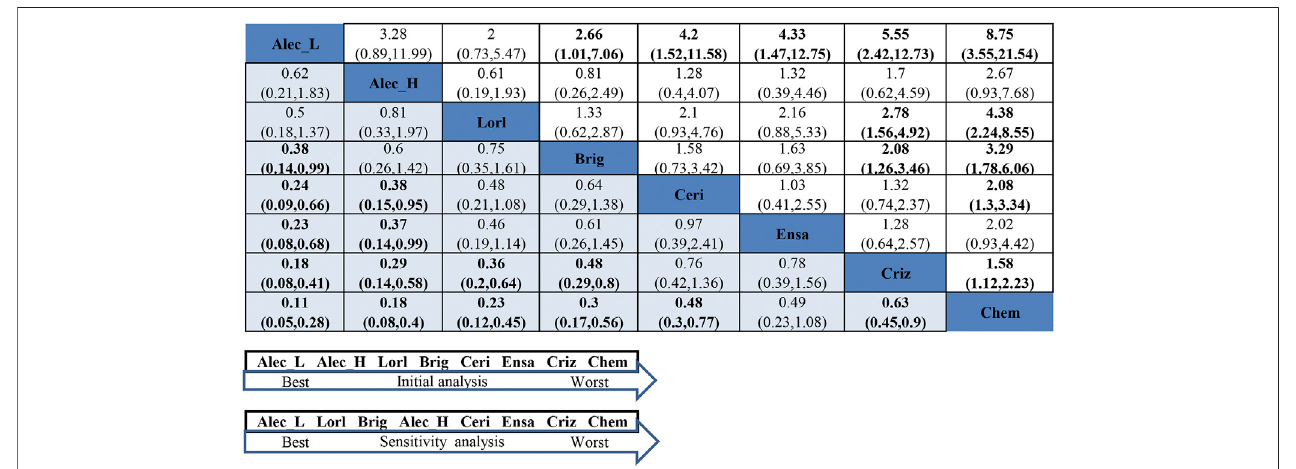
FIGURE 6 | NMA results of smokers on progression-free survival (lower left) and sensitivity analysis (upper right), followed by the ranking distribution according to SUCRA values (lower arrow shape). NMA, network meta-analysis; SUCRA, the surface under the cumulative ranking curve; Chem, chemotherapy; Criz, crizotinib; Ceri, ceritinib; Alec_L, low-dose alectinib; Alec_H, high-dose alectinib; Brig, brigatinib; Lorl, lorlatinib; Ensa, ensartinib. Values in bold mean statistically signi fi